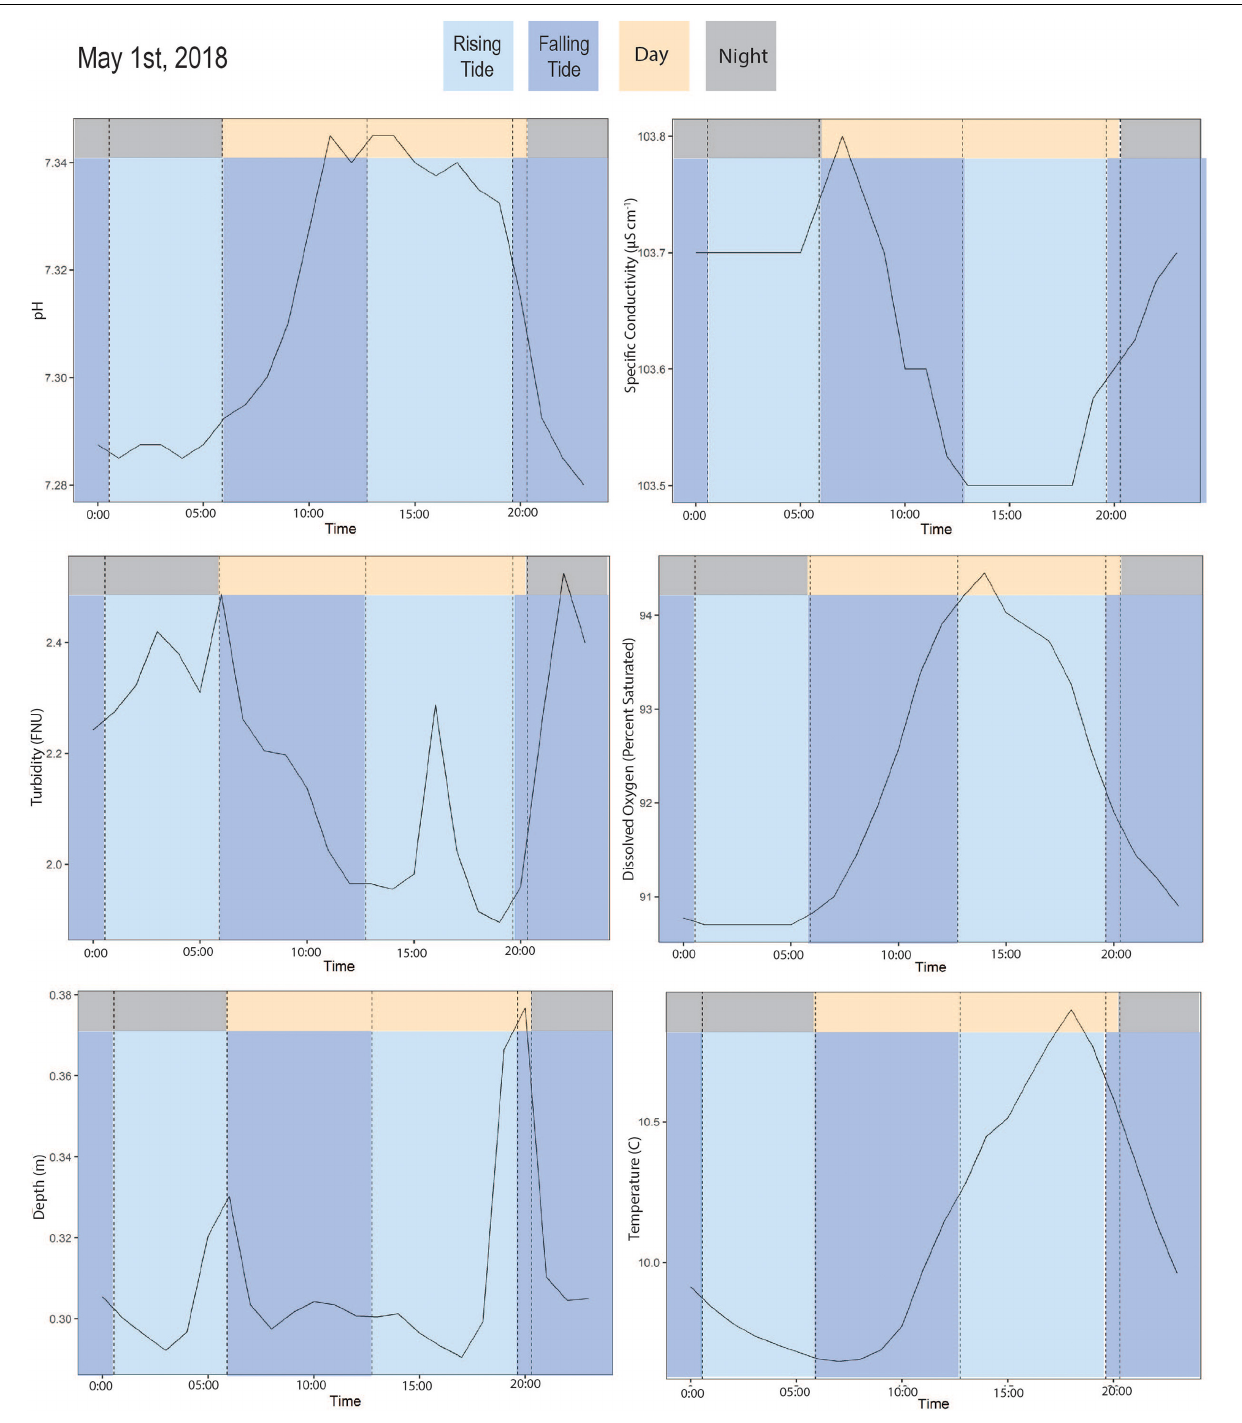
FIGURE 4 | Time series of example summer day (May 1st, 2018) averaged by hour of pH, specific conductivity, dissolved oxygen, turbidity, temperature, and depth. Colors indicate rising tide and falling tide (determined by timing of high and low tide) and day and night (determined by sunrise and sunset time).